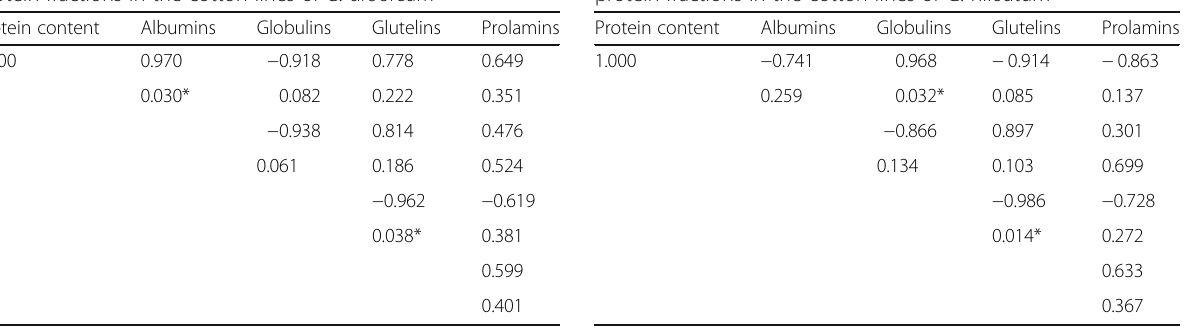
Table 8 Bivariate correlation between protein content and four protein fractions in the cotton lines of G. arboreum